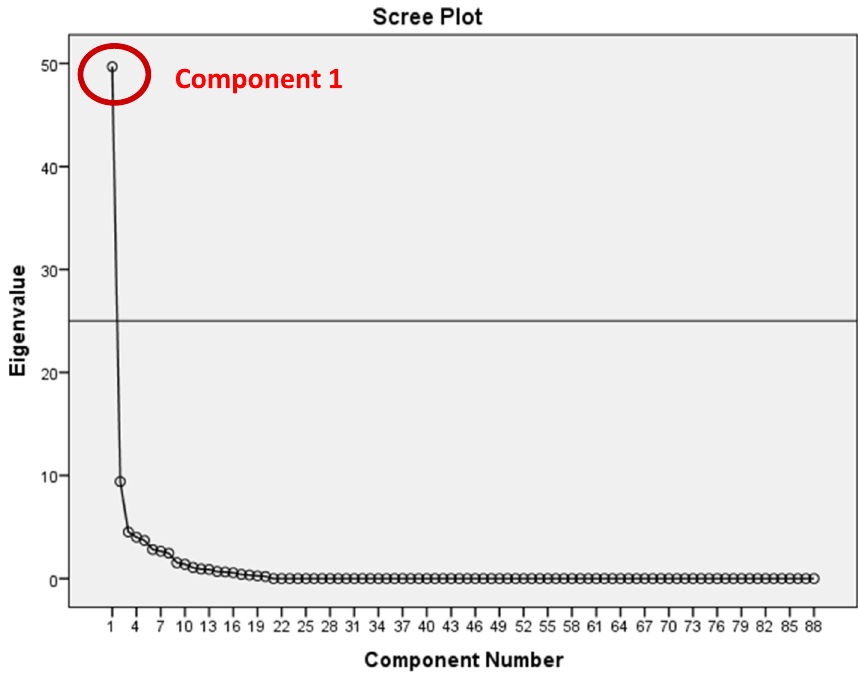
Fig. 10 Scree plot for the third runs (national variables)